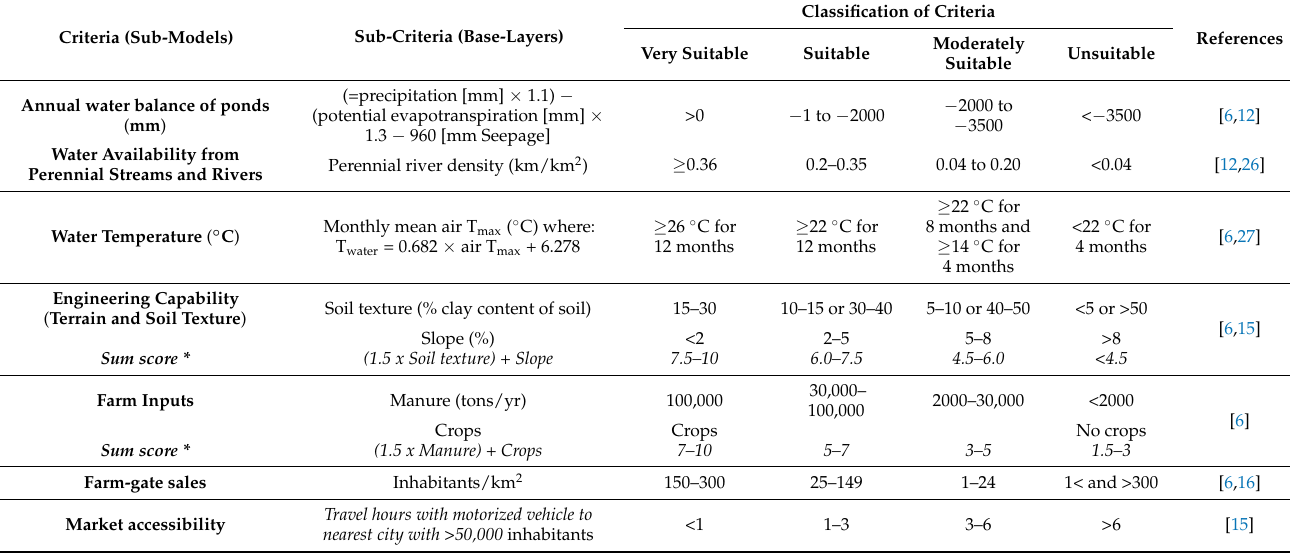
Table 1. Summary for criteria and sub-criteria with classification by thresholds into Very Suitable (VS), Suitable (S), Moderate Suitability (MS), and Unsuitable